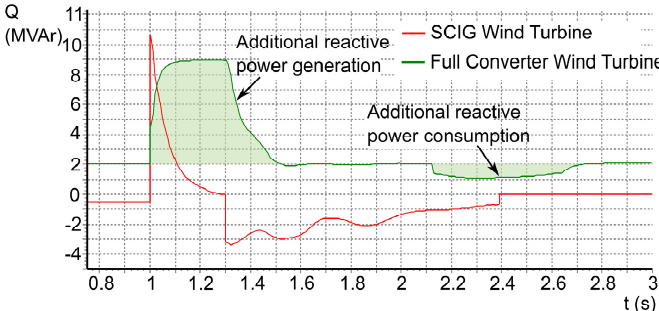
Figure 12. Reactive power generated or consumed by wind farm Number 2 in both the SCIG wind turbine case and the full converter wind turbine case, for a 300 ‐ ms three ‐ phase short circuit.